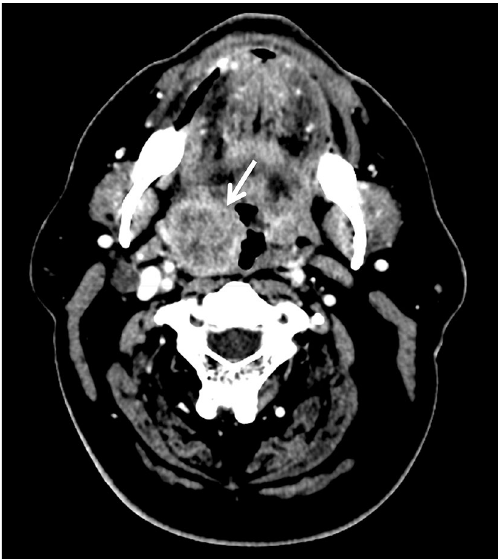
Figure 2. Axial CT slice showing well-defined contours of an exophytic P16+ tumour of the right palatine tonsil (arrow) in a 57-year-old male non-smoker.